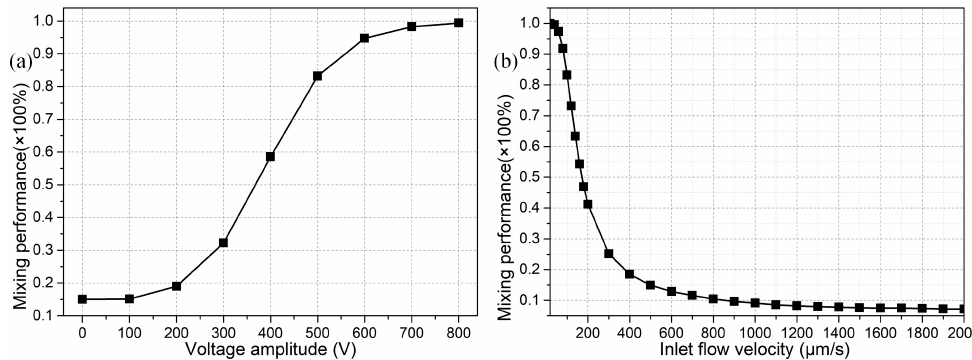
Figure 9. For given values of field frequency f = 100 kHz, inter-block separation L bb = 40 μ m and obstruction width W b = 80 μ m, ( a ) the effect of voltage amplitude on the mixing performance at an inlet flow rate of u 0 = 100 μ m/s; and ( b ) influence of inlet flow velocity on the fluid mixing behavior at A = 500 V.